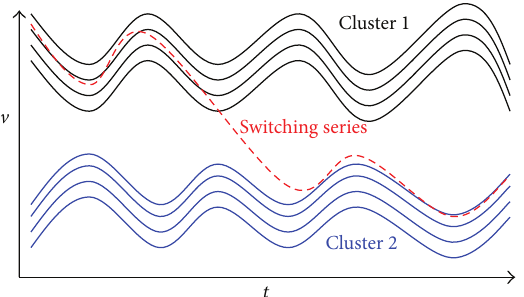
Figure 1: The dynamic behavior of switching time series over